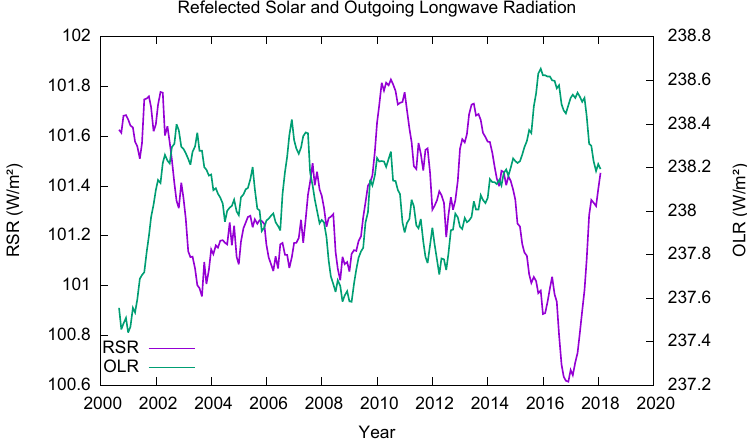
Figure 12. Purple curve: RSR. Green curve: OLR.